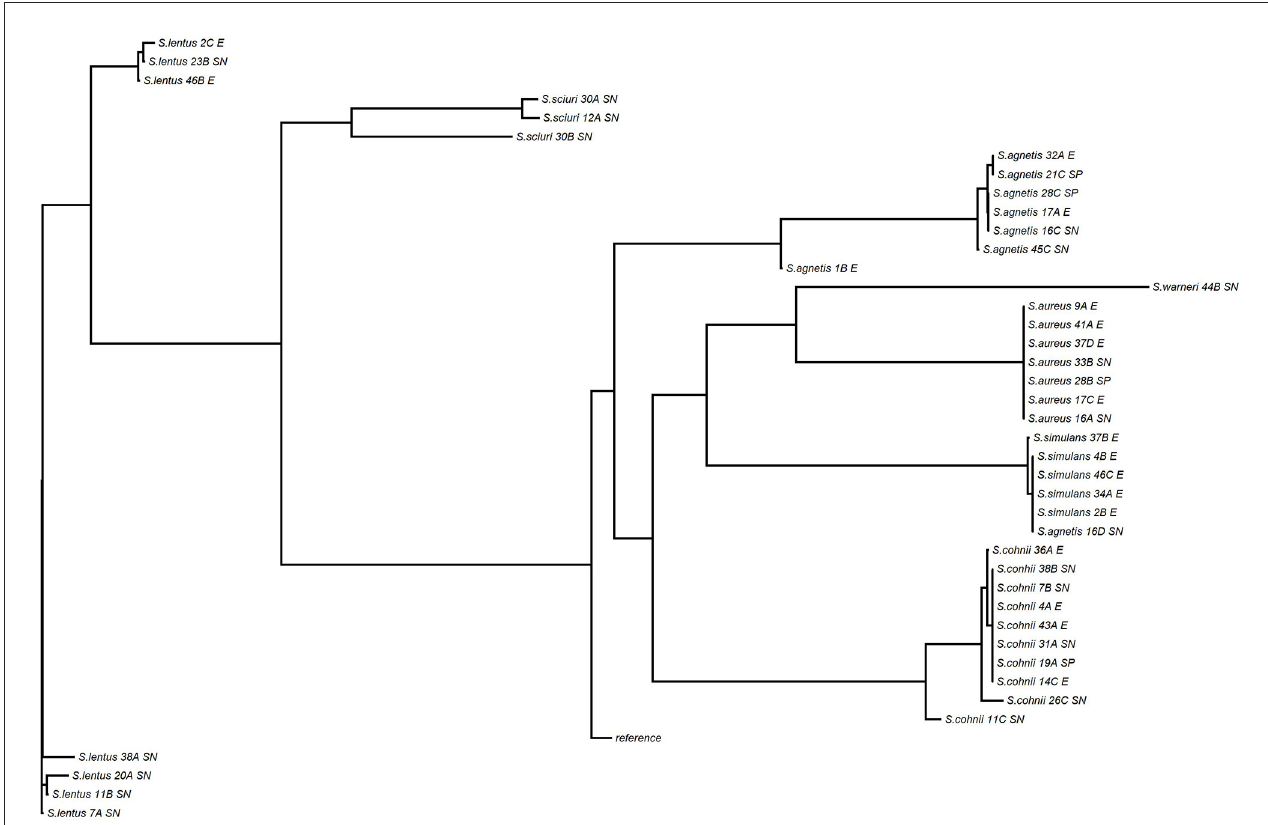
FIGURE8 Phylogenetic tree of Staphylococcus isolates from skin and environmental samples of Control and FUDS flocks.